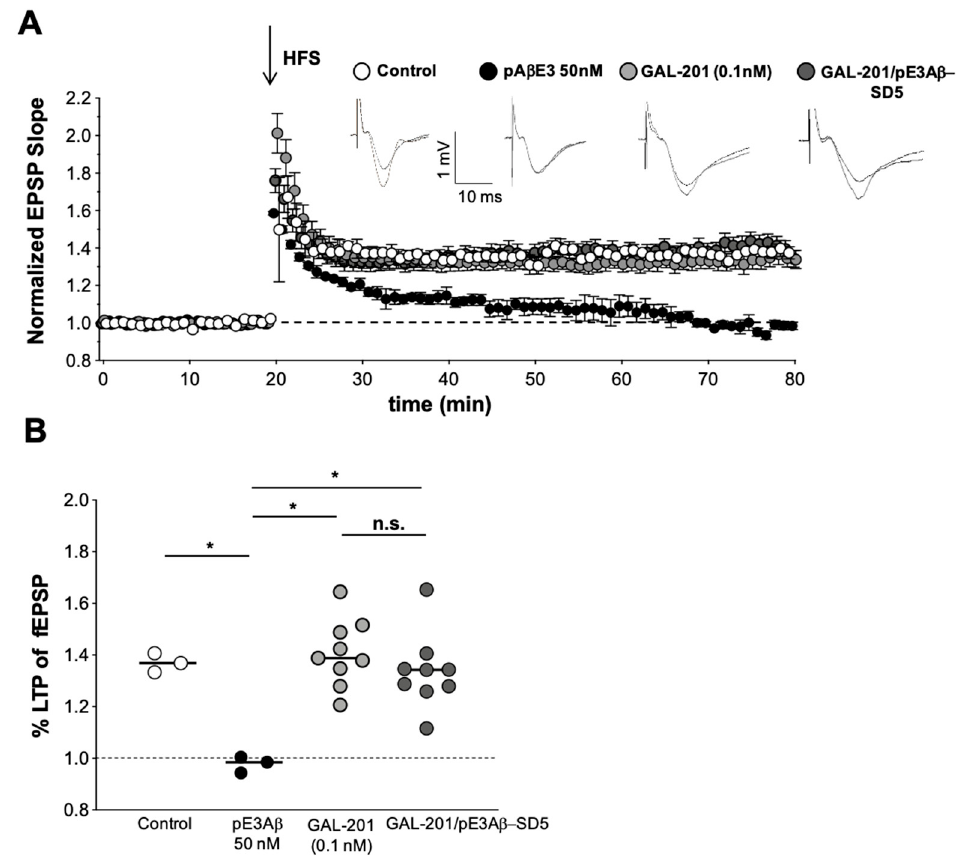
Figure 7. The toxic effects of A β pE3 (50 nM) upon LTP induction can be prevented when using GAL-201/A β pE3-SD5 solution from serial dilution. ( A ) Under control conditions, LTP was induced in one input (open circles) and in the presence of 50 nM of A β pE3 (closed circles). These interleaved experiments have been performed to ensure the validity of the A β pE3-mediated effect. The strong synaptotoxic effect of A β pE3 was demonstrated as LTP was completely blocked. In a separate slice, LTP has been delivered (input one) in the presence of 0.1 nM GAL-201 (light grey circles) which did itself not affect LTP. The GAL-201/A β pE3-SD5 solution generated from A β pE3 (initiated with GAL-201) through serial dilution was applied 90 min before HFS delivery in the second input (dark gray circles) and prevented LTP blockage. Representative fEPSPs are shown on top. ( B ) Scatter dot plot summarizing the last 50 to 60 min after HFS for all groups. (* p < 0.05).